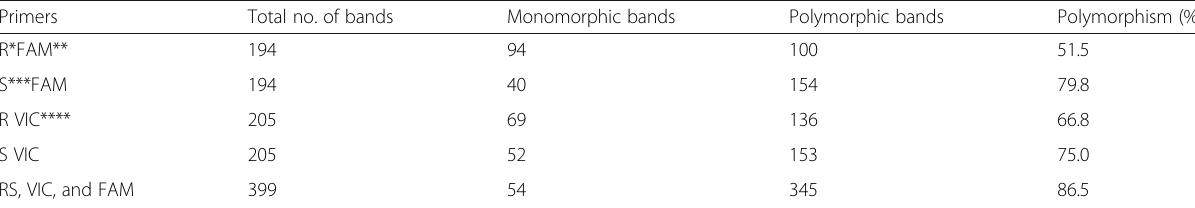
Table 3 Summary of the polymorphisms detected by AFLP system in 20 samples of the selected resistant population (FSEQLD7R) and 20 samples of the susceptible population (FBTARPBS) of flaxleaf fleabane